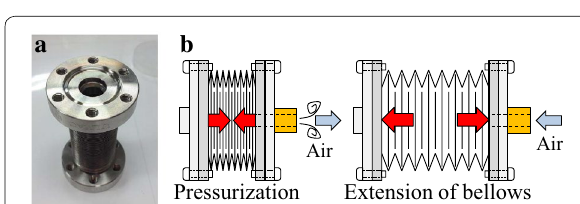
Fig. 14 Metal bellows. a Photo. b Cross section and its